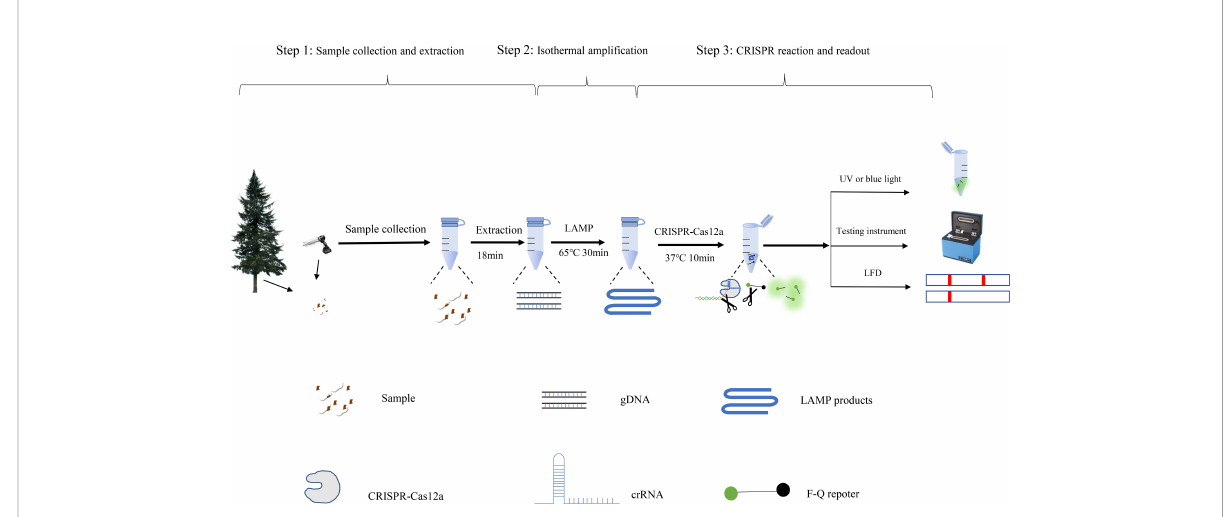
FIGURE 6 Processing scheme for the LAMP-CRISPR/Cas12a assay includes the following steps: DNA extraction, isothermal ampli fi cation reactions, and CRISPR-Cas12 detection of the B xylophilus by fl